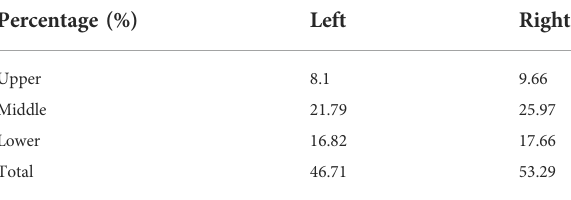
TABLE 3 Percentage of inferior vena cava fl ow by radionuclide lung perfusion. Percentage (%) Left